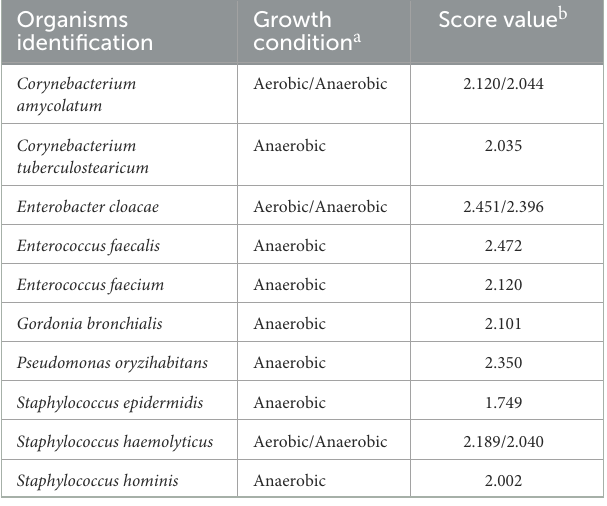
TABLE 1 Comparison of two mycobacterial isolates (the same strain) from extrapulmonary (skin ulcer) and respiratory (sputum/BAL) niches.